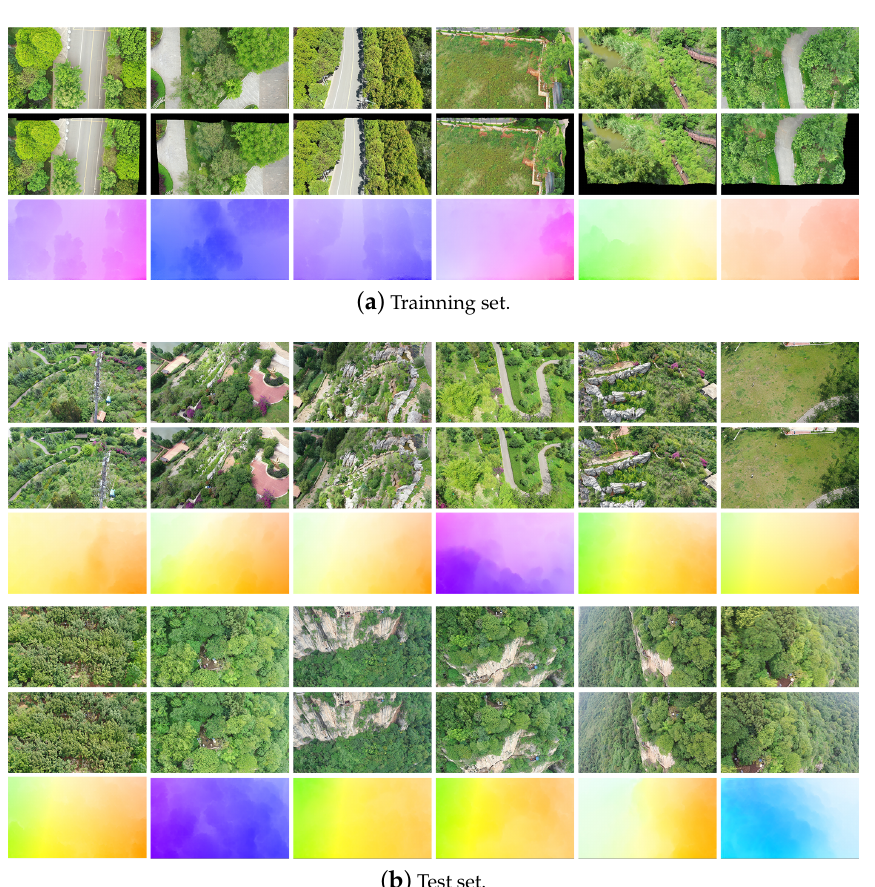
Figure 3. Parts of dataset are shown. Each piece of data are divided into three parts, A (first row), B (second row), and flow (third row). Flow is the pixel motion relationship from A to B. In the training set, A is the original image and B is the reprojected image. In the test set, A is the previous frame image and B is the current frame image.